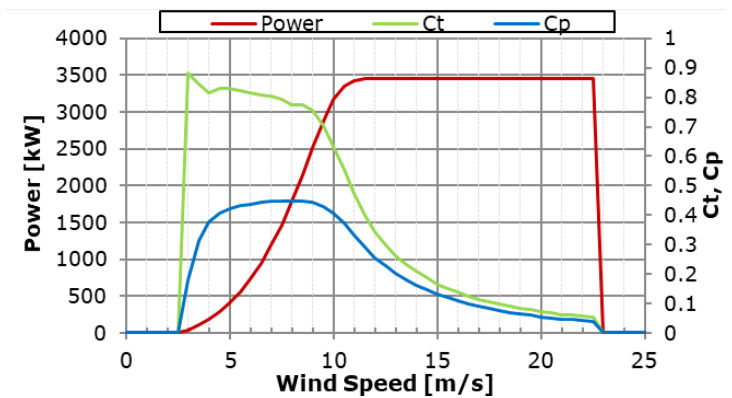
Figure 12. Power curve of the Vestas V126-3.45 HTq, turbine